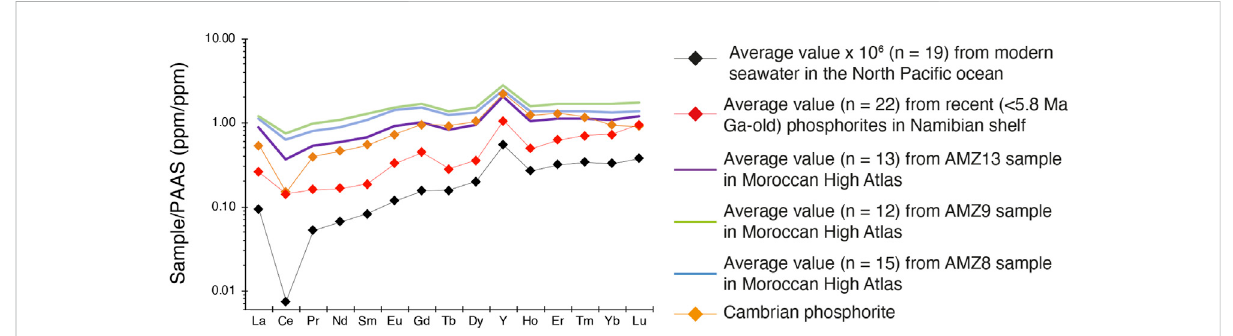
FIGURE 6 Average PAAS-normalized REEY values of Amizmiz phosphorites from the Moroccan High Atlas (blue, green, and purple lines) compared with theaverageREEY SN spectrumofmodernseawater(AliboandNozaki,1999;blackline),recentmarinephosphorites(Lumisteetal.,2019;redline)and unaltered Cambrian phosphorite (IX-25, Shields and Stille, 2001; orange line). Seawater-like patterns in the Amizmiz samples are preserved with no MREE arching. Data from this study and Lumiste et al. (2019) were collected by LA-ICP-MS, while Shields and Stille ’ s (2001) and Alibo and Nozaki ’ s (1999) values come from bulk ICP-MS analyses. PAAS values are from Taylor and McLennan